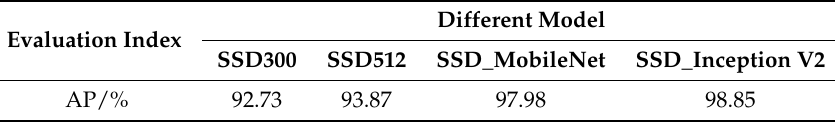
Figure 10. The detection results of lateral growth cherry tomatoes. ( a ) the result of SSD300 model, ( b ) the result of SSD512 model, ( c ) the result of SSD_MobileNet model and ( d ) the result of SSD_Inception V2 model. Table 6. Comparison test of different